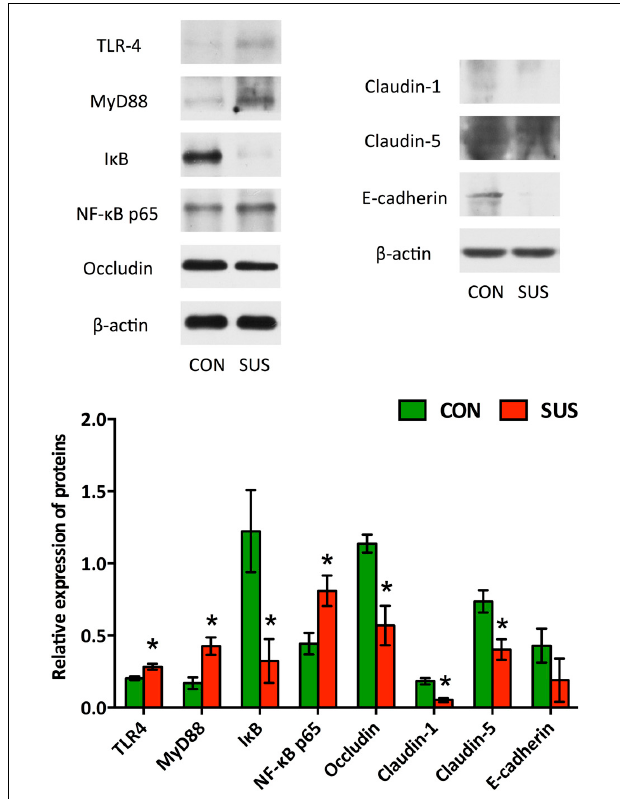
FIGURE 2 | Effects of simulated weightlessness on the expressions of occludin, claudin-1, claudin-5, TLR-4, MyD88, I κ B and NF- κ B p65 in ileum. CON, control group; SUS, simulated weightlessness group. Data are representative as means ± SEM. ∗ P < 0.05, compared with the control